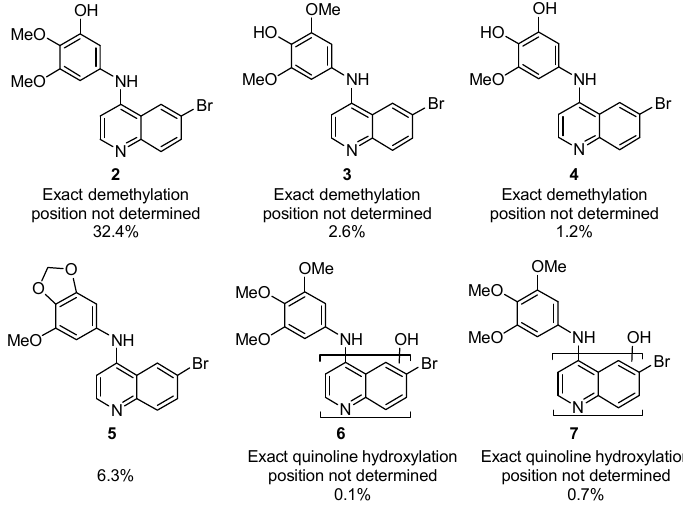
Figure 2. Metabolites of 1 identified ( 2 – 7 ) along with percentage abundance in respect to the parent compound. Compounds are ordered by HPLC retention time (see Supplementary Materials).